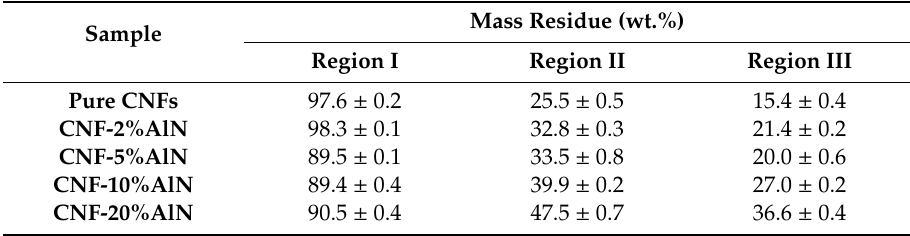
Figure 9. Thermogravimetric (TG) curves of pure CNFs and CNF-AlN composites. Table 1. Thermal stability of CNF-AlN composites.